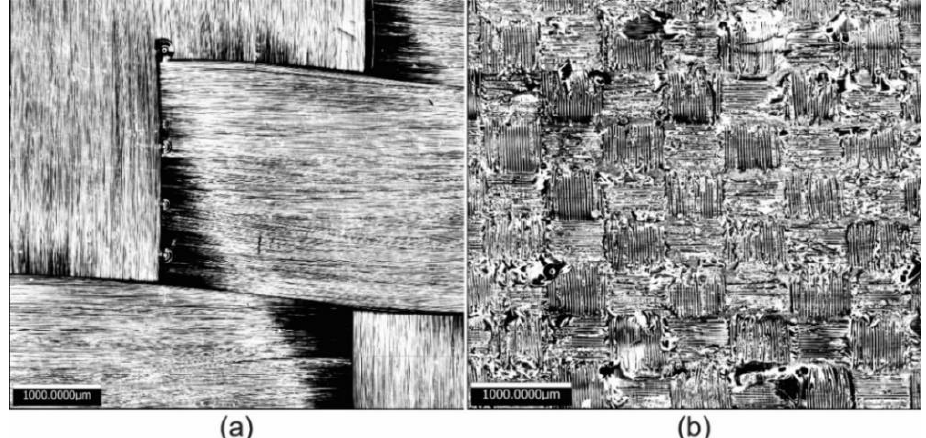
Figure 1. RI process for the manufacture of composite materials.